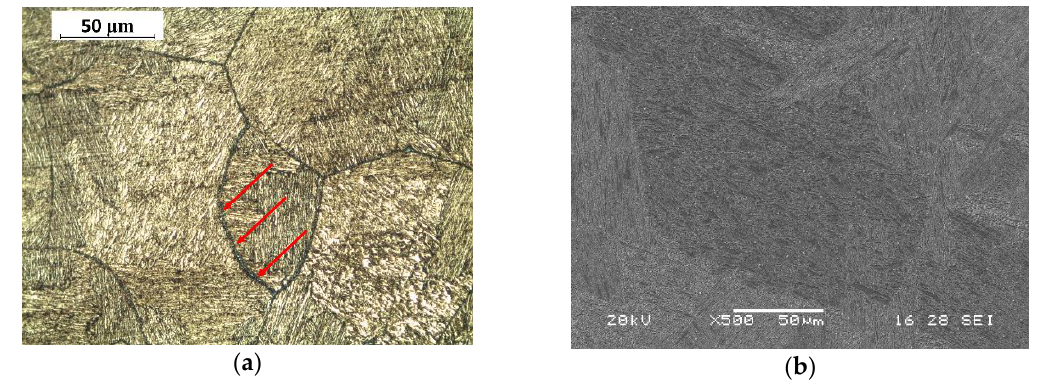
Figure 2. ( a ) Light microscope image (red arrows indicate carbides) and ( b ) SEM image of group X steel microstructure.